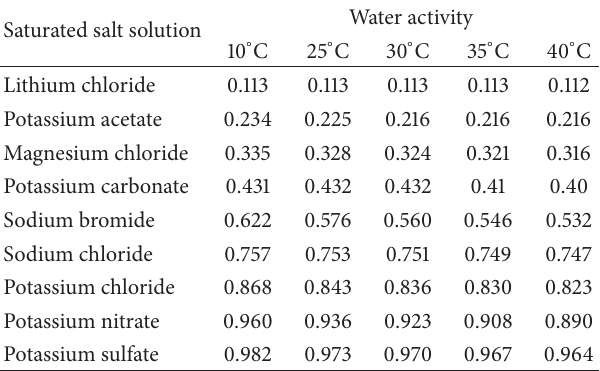
Table 1: Water activity of saturated salt solutions at five different temperatures.